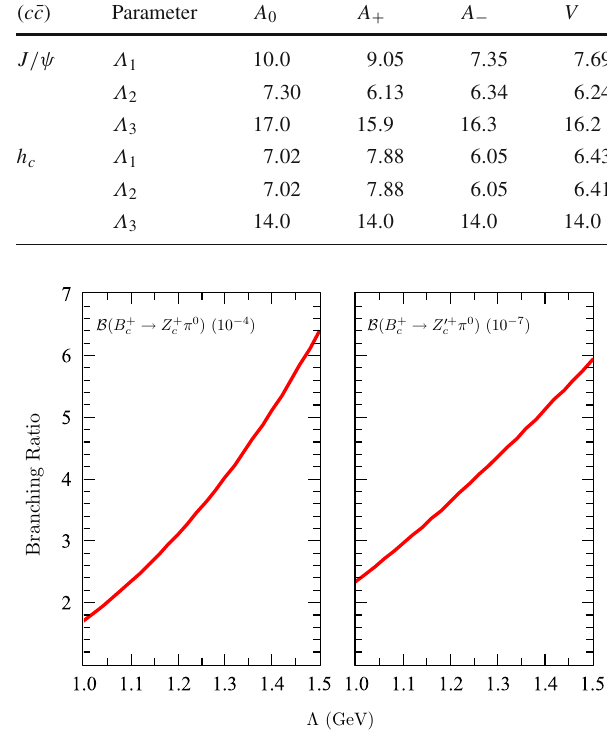
where the values of Λ 1 , Λ 2 and Λ 3 are obtained by fitting Eqs. (15) and (16) with Eq. (17) and the fitted parameter values are list in Table